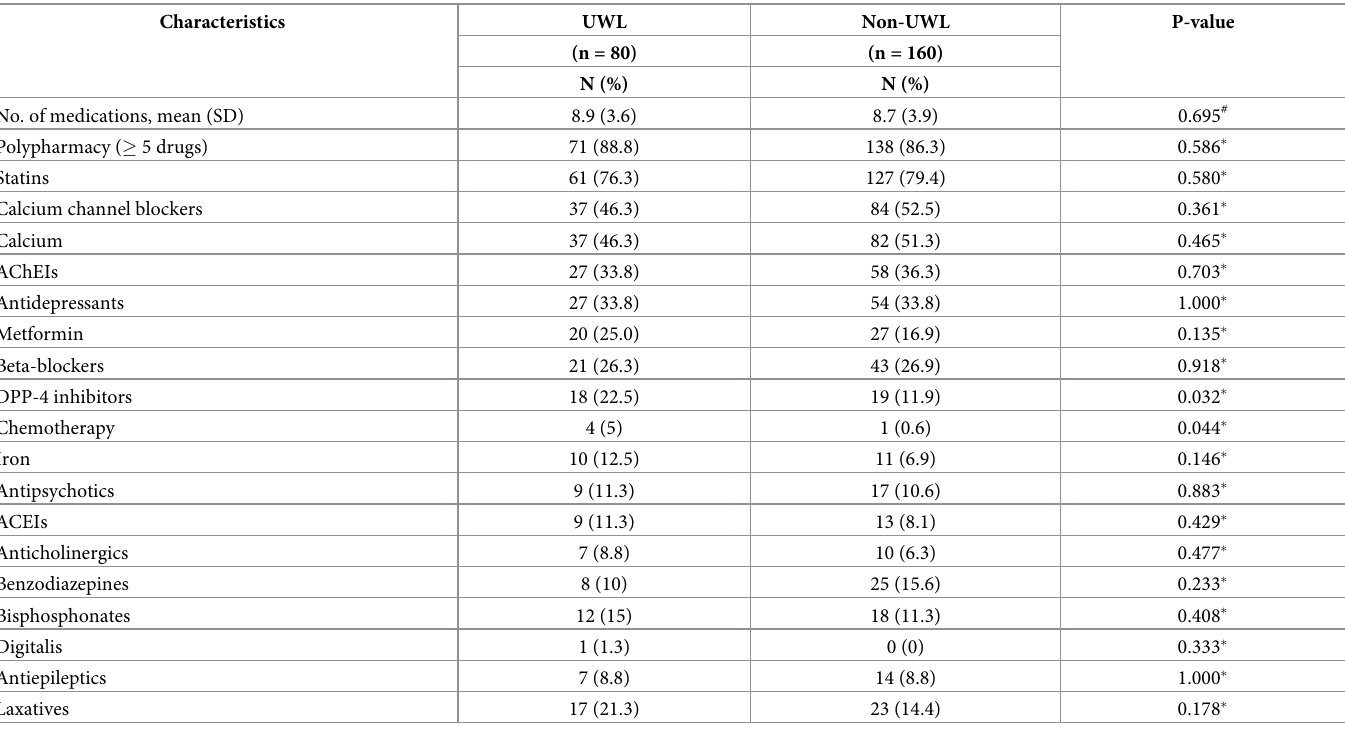
Table 4. Prescribed medication use among older patients in the geriatric outpatient clinic.